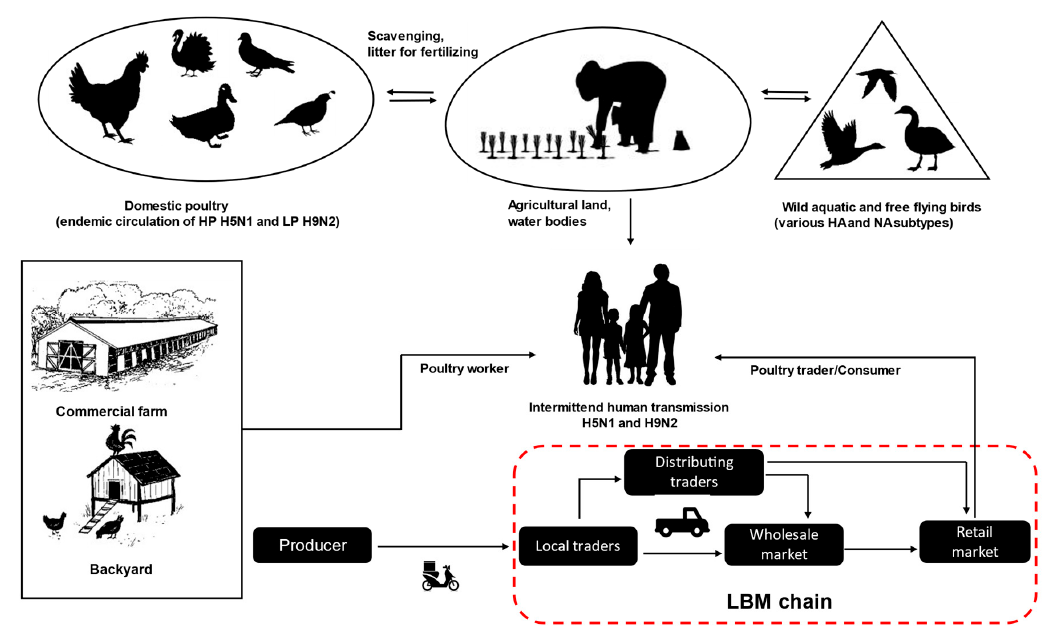
Figure 1. An overview of avian influenza virus transmission and live bird market trading chains (red dashed line) in Bangladesh.